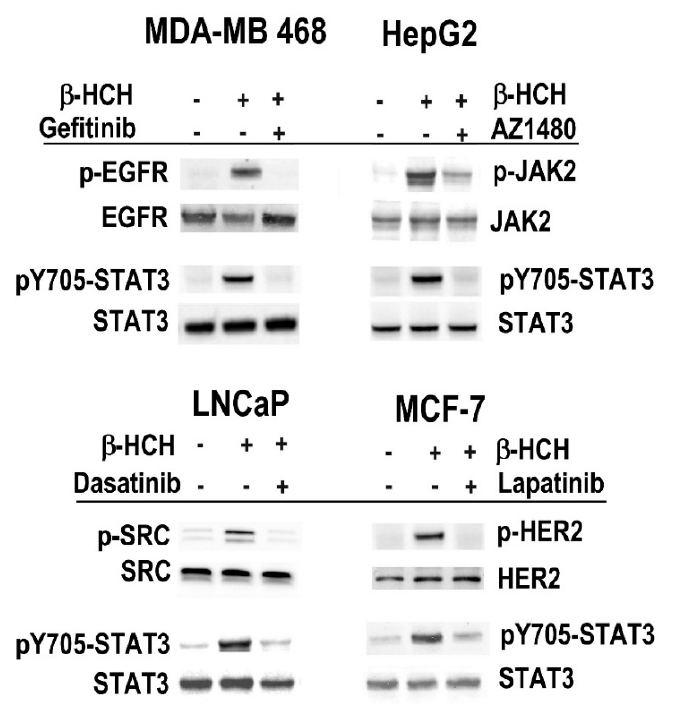
Figure 2. Inhibition of specific signaling pathways activated by β‐ HCH. Each cell line was treated with 10 μ M β‐ HCH in the presence or absence of specific inhibitors: Gefitinib as EGFR inhibitor in MDA ‐ MB 468 cells; AZD1480 as JAK2 inhibitor in HepG2 cells; Dasatinib as SRC inhibitor in LNCaP cells; and Lapatinib as HER2 inhibitor in MCF ‐ 7 cells. Cells were incubated (15 min for MDA ‐ MB 468, HepG2, and LNCaP cells and 2 h for MCF ‐ 7 cells) and cellular extracts were subjected to immunoblot analysis. Detection of the unmodified and corresponding phosphorylated form was carried out using specific